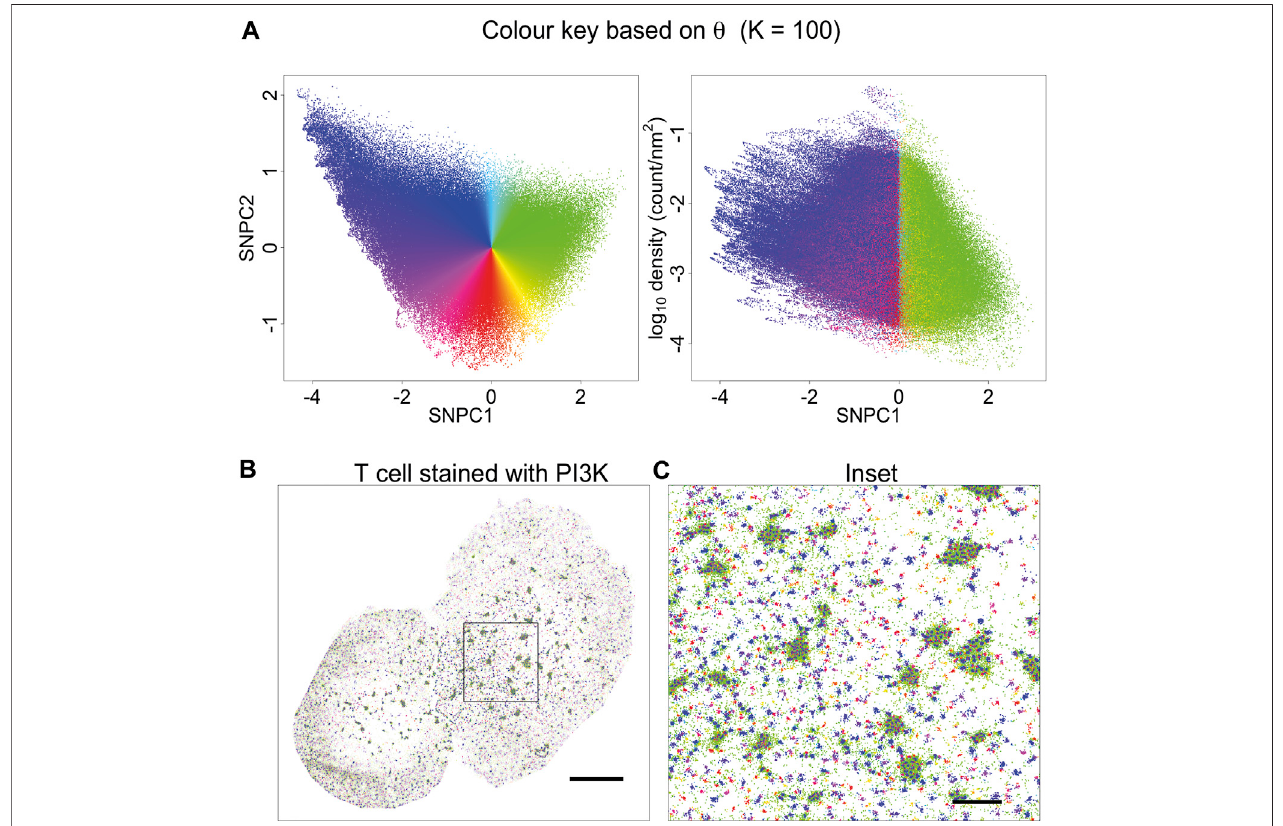
FIGURE 4 | Visualisation based on theta for K (cid:1) 100. (A) A novel visualisation is constructed by converting θ to hue. (B) PAINT image of T cell stained with PI3K probe,andcolouredaccordingto (A) .Thischoiceofvisualisationhighlightsclustersize(orlocalaggregationwithinmicroclusters)andcontrastsaggregation(blue,violet, magenta,red,orange)withsegregation(green). (C) Insetof (B) .Thisvisualisationislimitedinthatitisonlybasedonasingleparameter. Otherinformationissuppressed, forexample,segregatedpoints(green)haveadifferentdensitywithinoroutsidemicroclusters.Thisindicatesthattheyarisefromdifferentprocesses:theyoccurin- between tightly packed molecules within microclusters, and as spurious noise outside the